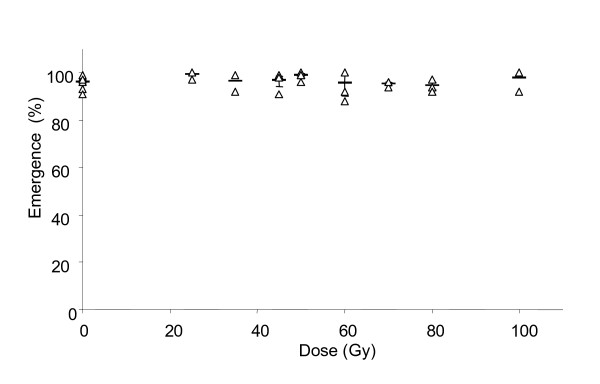
Adult emergence for the different treatments. Triangles indicate individual values; detransformed means (± SE, if n>2) are indicated by a horizontal line.